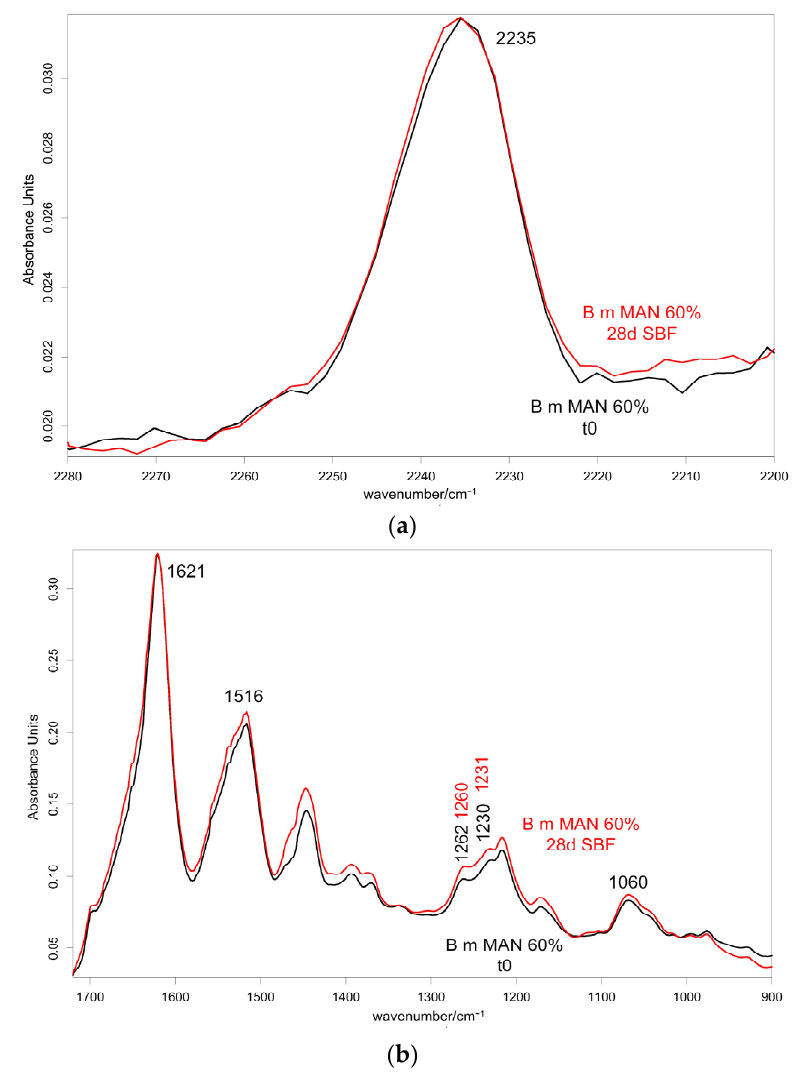
Figure 14. IR spectra recorded in the parallel orientation on the 60% MAN-grafted fibers before and after ageing for 28 days in SBF in the 2280–2200 cm − 1 ( a ) and 1720–900 cm − 1 ( b ) spectral ranges.